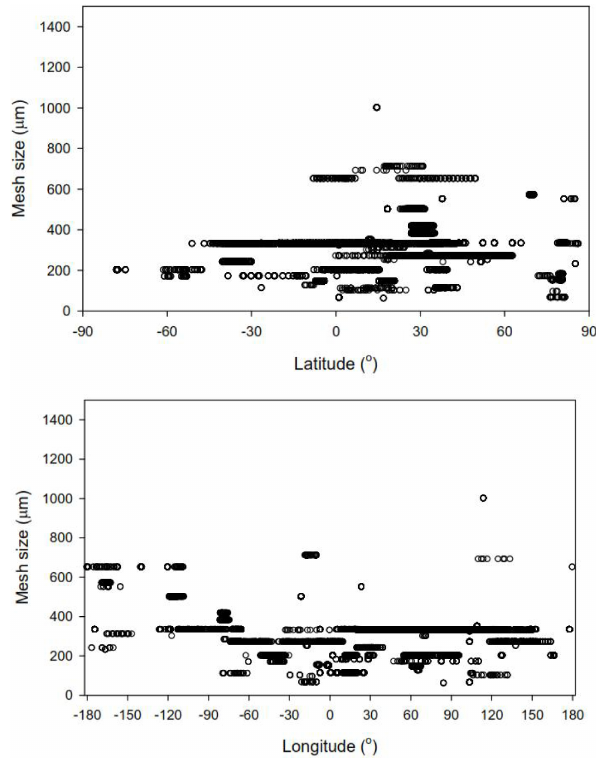
Figure 2. Net-mesh size versus longitude (above) and latitude (be- low). Data was excluded if multiple mesh sizes were